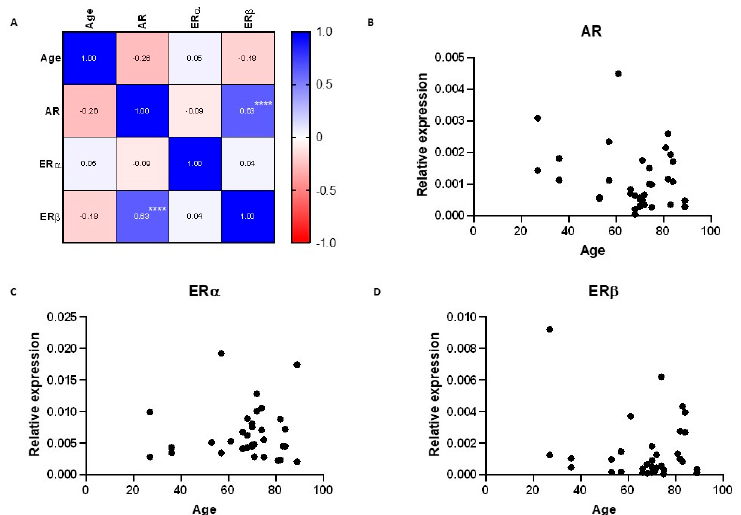
Figure 3. Correlation between the mRNA expression of sex steroid receptors in the human lacrimal gland and correlation of their expression with age. ( A ) Correlation matrix showing correlation coefficients between age and sex steroid receptor expression. ( B – D ) Scatter plots showing the relationships between patients’ age and AR, ER α , and ER β expression, respectively. **** p <